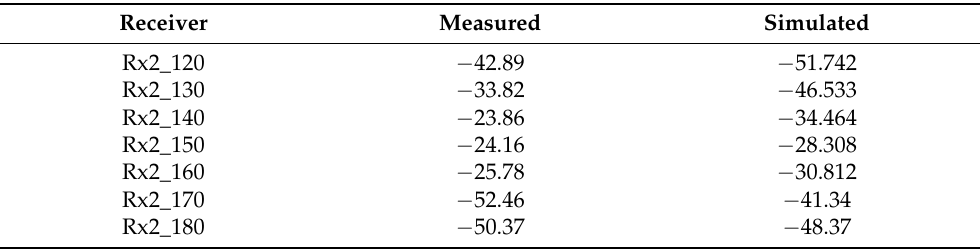
Table 3. Performance comparison between simulation and measurements at Rx2 (120–180 ◦ ) for LOS component.